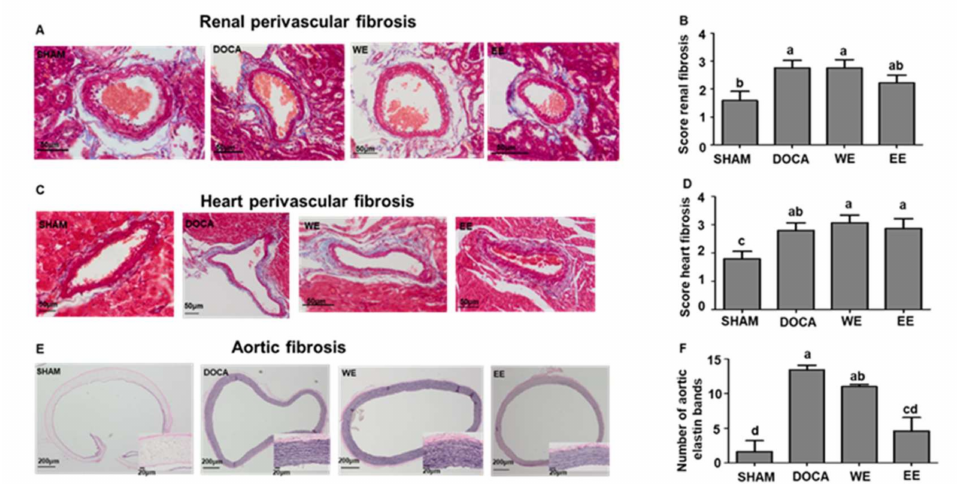
Figure 3. Effects of the water extract and ethanol extract of L. rhamnosus AC1-fermented soymilk on tissue fibrosis in DOCA-salt hypertensive rats. Representative figure and quantification of renal perivascular fibrosis ( A , B ); Representative figure and quantification of heart perivascular fibro- sis ( C , D ); Representative figure and quantification of aortic fibrosis ( E , F ). Data are presented as means ± SEM ( n = 6). Bar values bearing different letters were significantly different by Duncan’s multiple range test ( p <